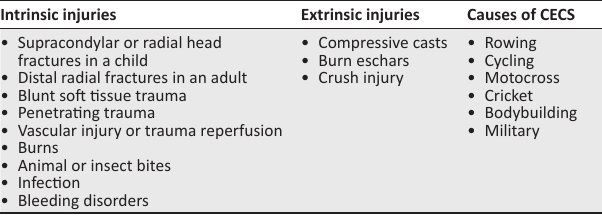
FIGURE 1: Algorithm detailing the pathophysiology of compartment syndrome, based on the theory of Matsen. TABLE 1: Causes of compartment syndromes.